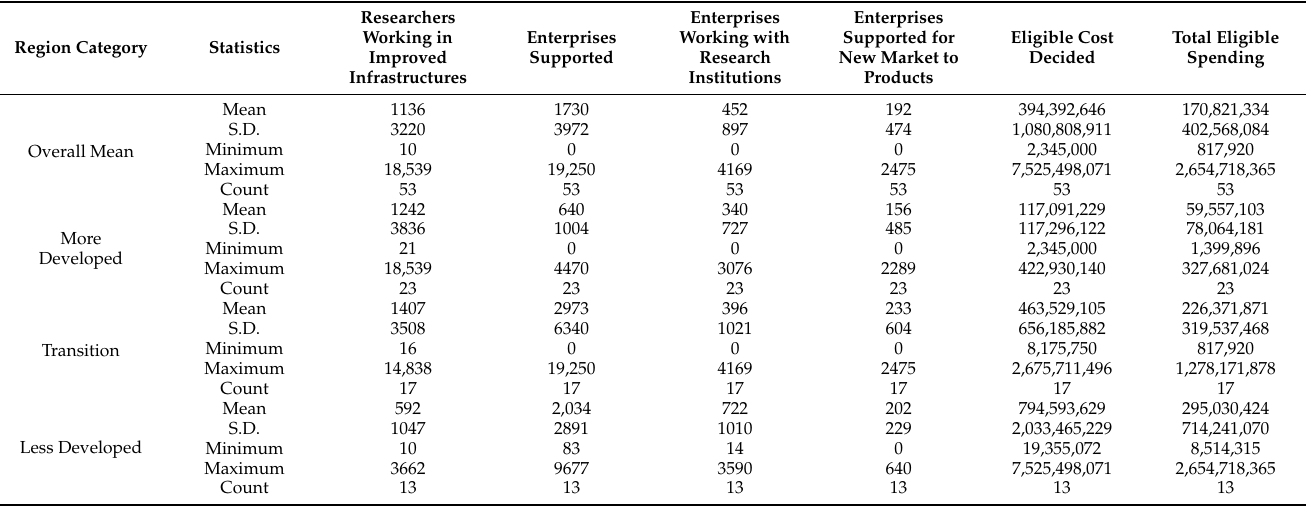
Table 4. Descriptive Statistics per region category.